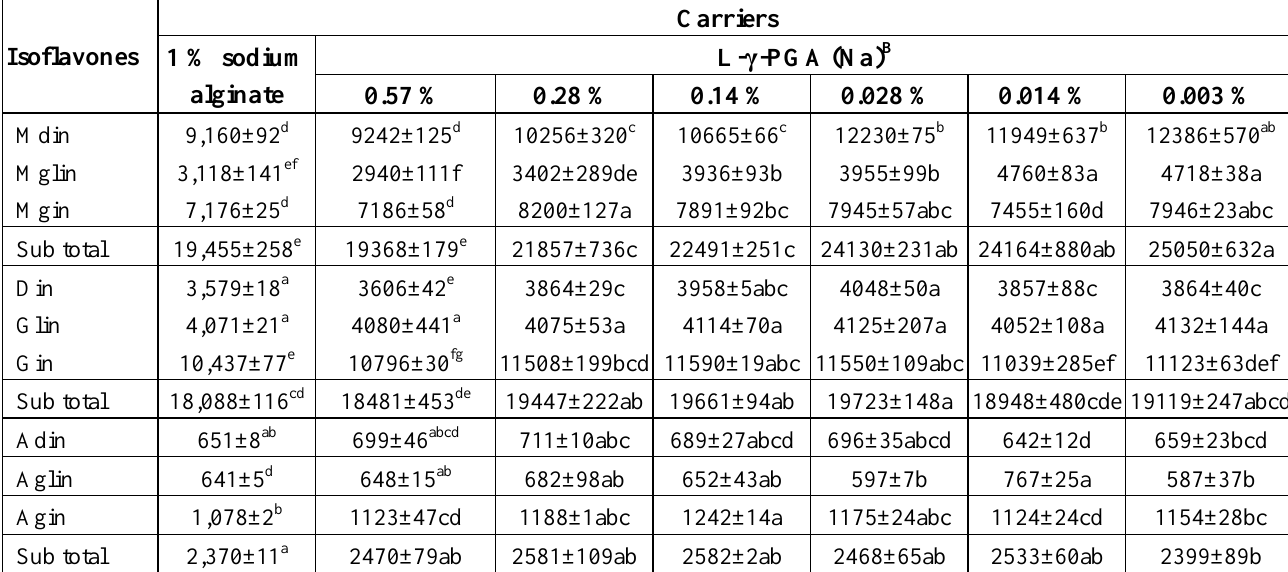
Table 5. Isoflavone contents (µg/g) A in the freeze-dried powder with L- γ -PGA (Na) B or sodium alginate as carrier C